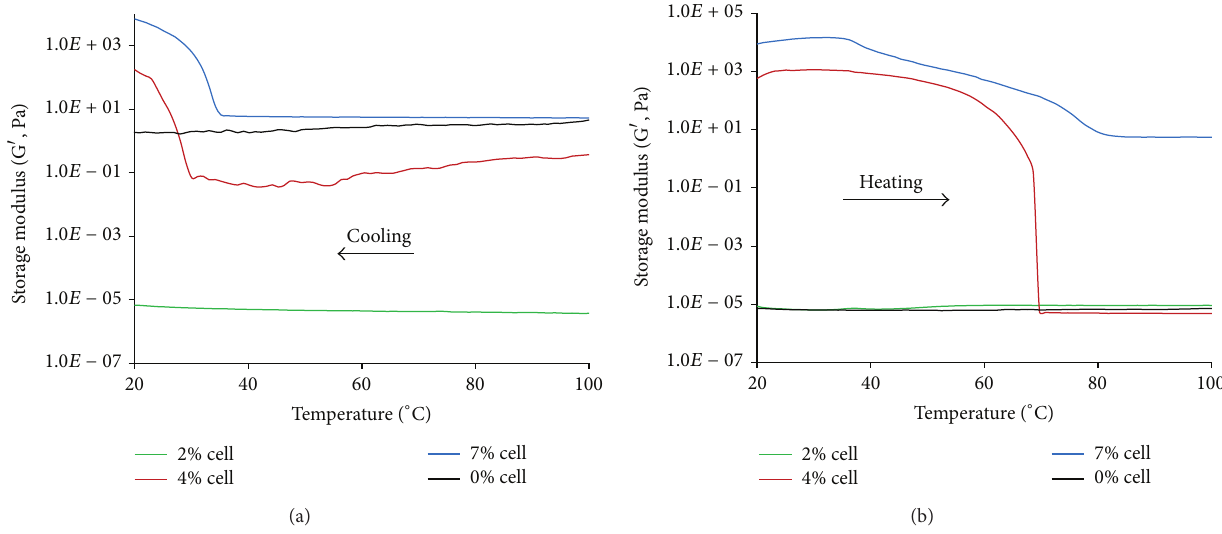
Figure 3: Effect of cellulose concentration of storage modulus with temperature for EMIMOAc solutions on cooling (a) and heating (b). Pure EMIMOAc (black), 2% cellulose (green), 4% cellulose (red), and 7% cellulose (blue)